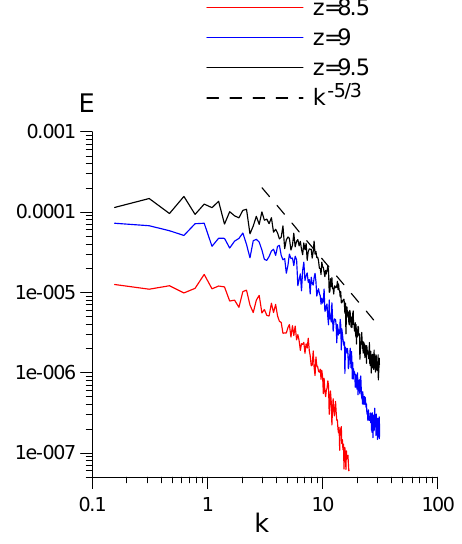
Fig. 3a. Turbulence power spectrum obtained in DNS with the forc- ing on and no initially excited IWs at t = 300 at different z-levels. Fig.3a. Turbulence power spectrum obtained in DNS with the forcing on and no initially excited Dashed line shows the Kolmogorov’s k 3 / 5 spectrum asymptotics. 3/5 − k IWs at t = 300 at different z-levels. Dashed line shows the Kolmogorov’s spectrum Here and in Figs. 4–7 below, the forcing amplitude is F 0 = 3 asymptotics. Here and in Figs.4-7 below, the forcing amplitude is = F . 0